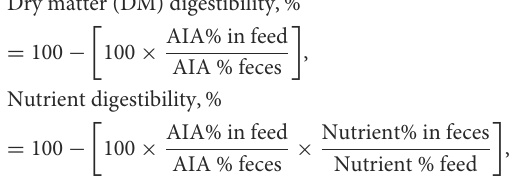
TABLE 3 Fiber fractions % of feedstuffs and experimental rations.